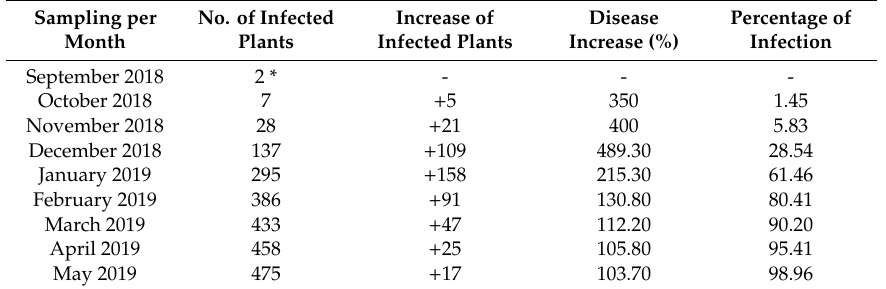
Table 4. Trend of Tomato brown rugose fruit virus infection during the 9 months of investigation. Sampling per Month